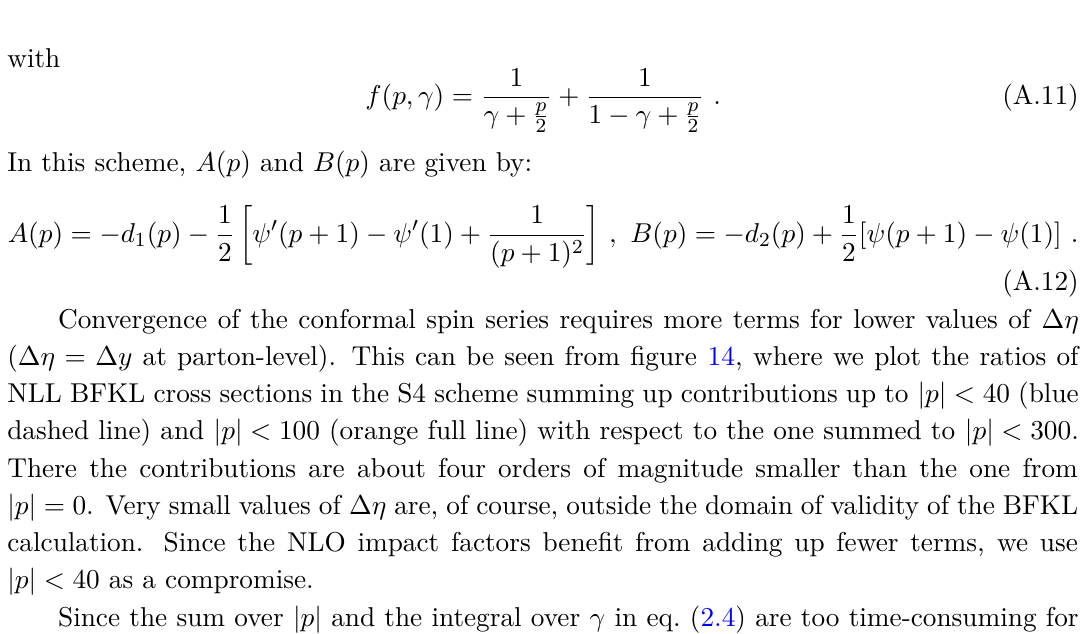
Figure 14 . NLL BFKL cross section ratios summing up contributions up to | p | < 40 (blue dashed line) and | p | < 100 (orange full line) with respect to the one summed to | p | < 300 . The contribution from | p | = 300 is about four orders of magnitude smaller than the one from | p | = 0